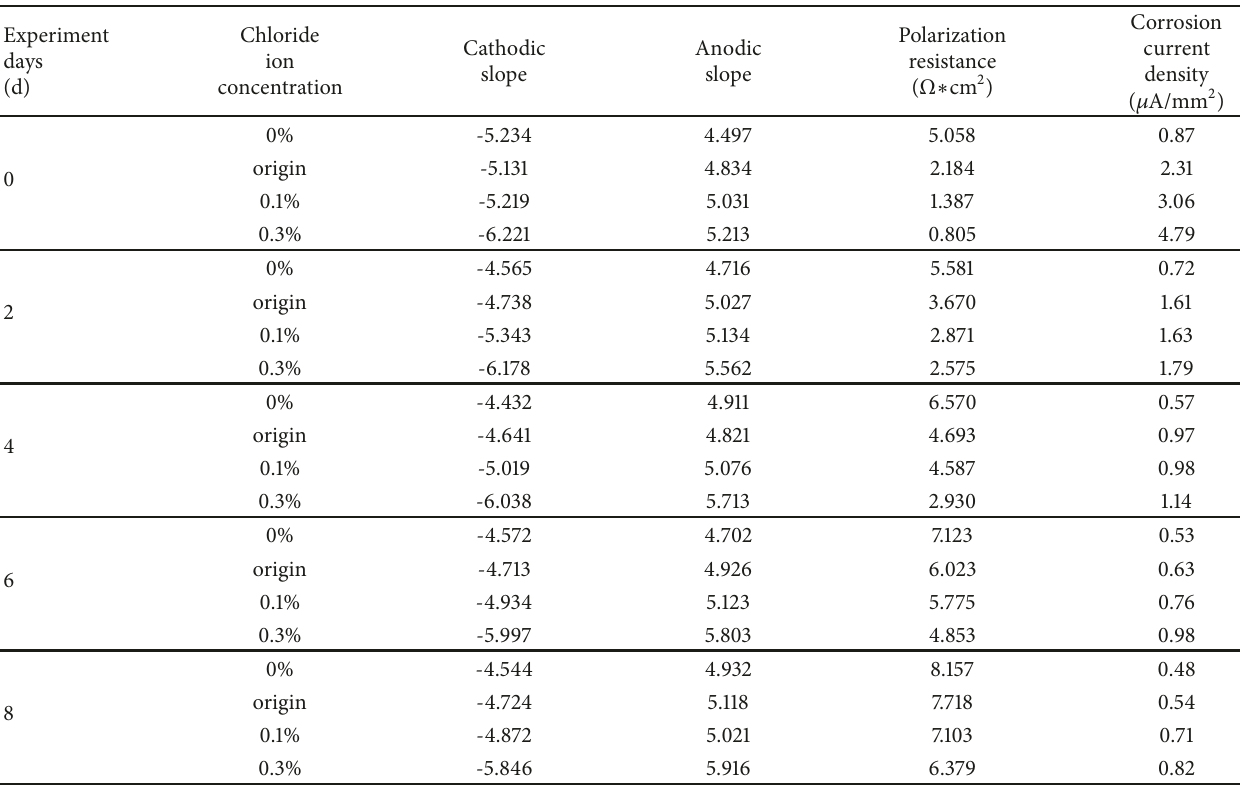
Table 5: The corrosion electrochemical parameters of the anode under different chloride ion concentration conditions.